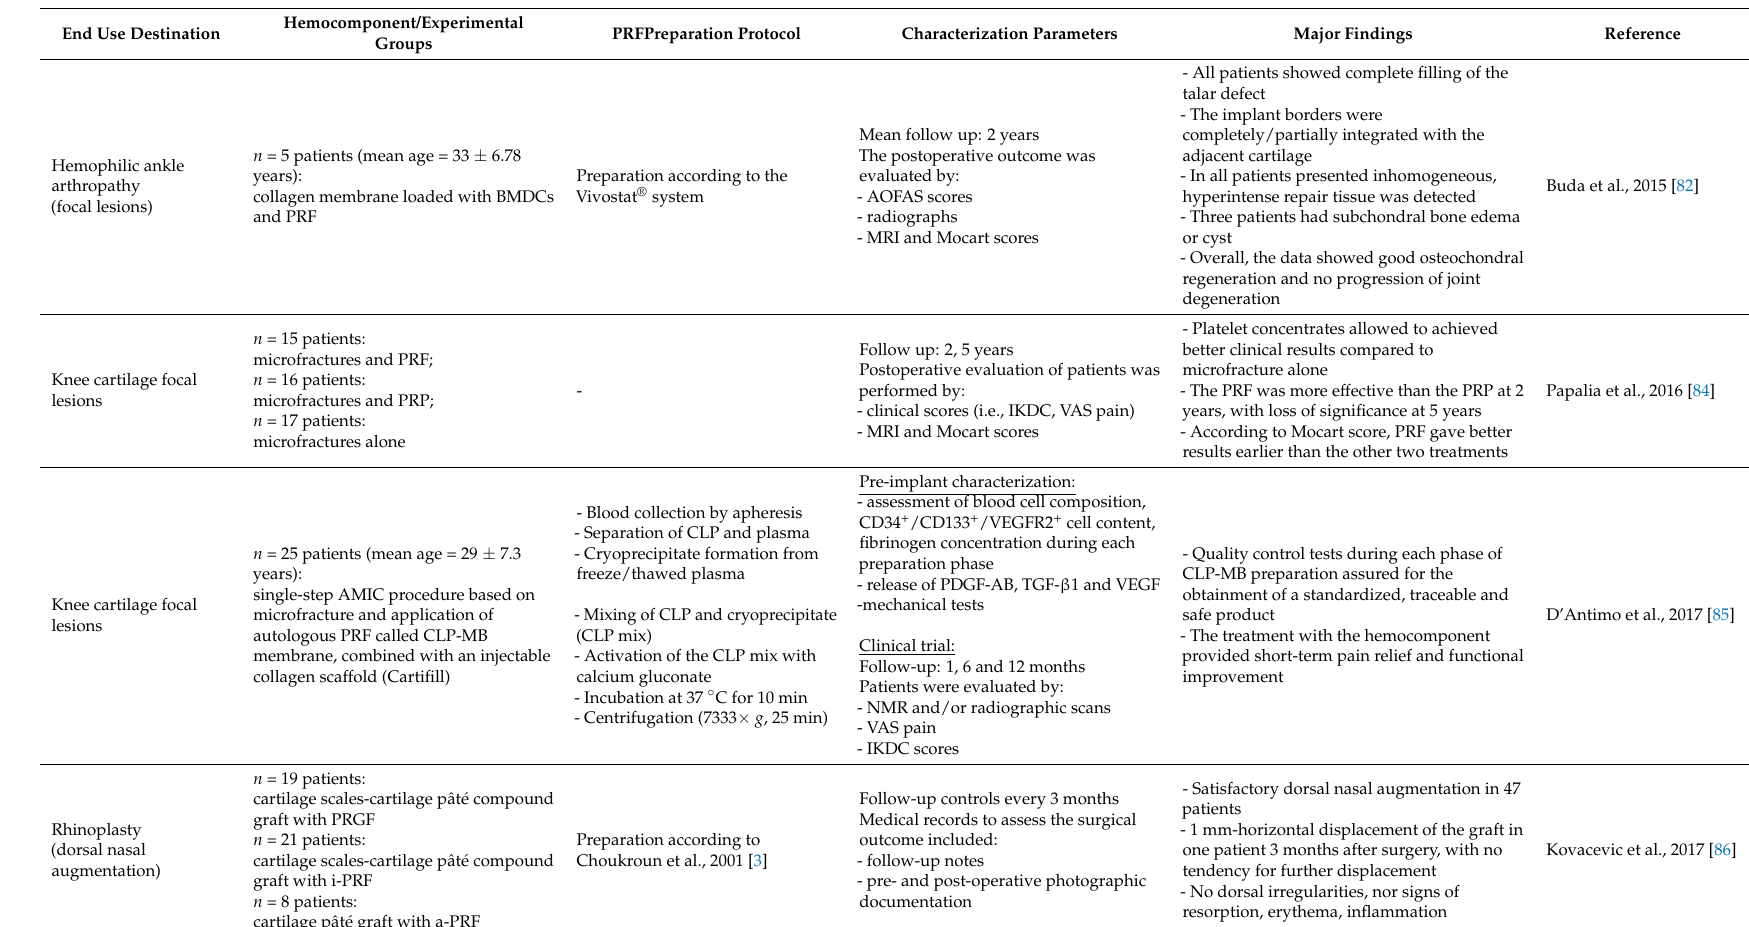
Table 3. Clinical application of PRF for cartilage